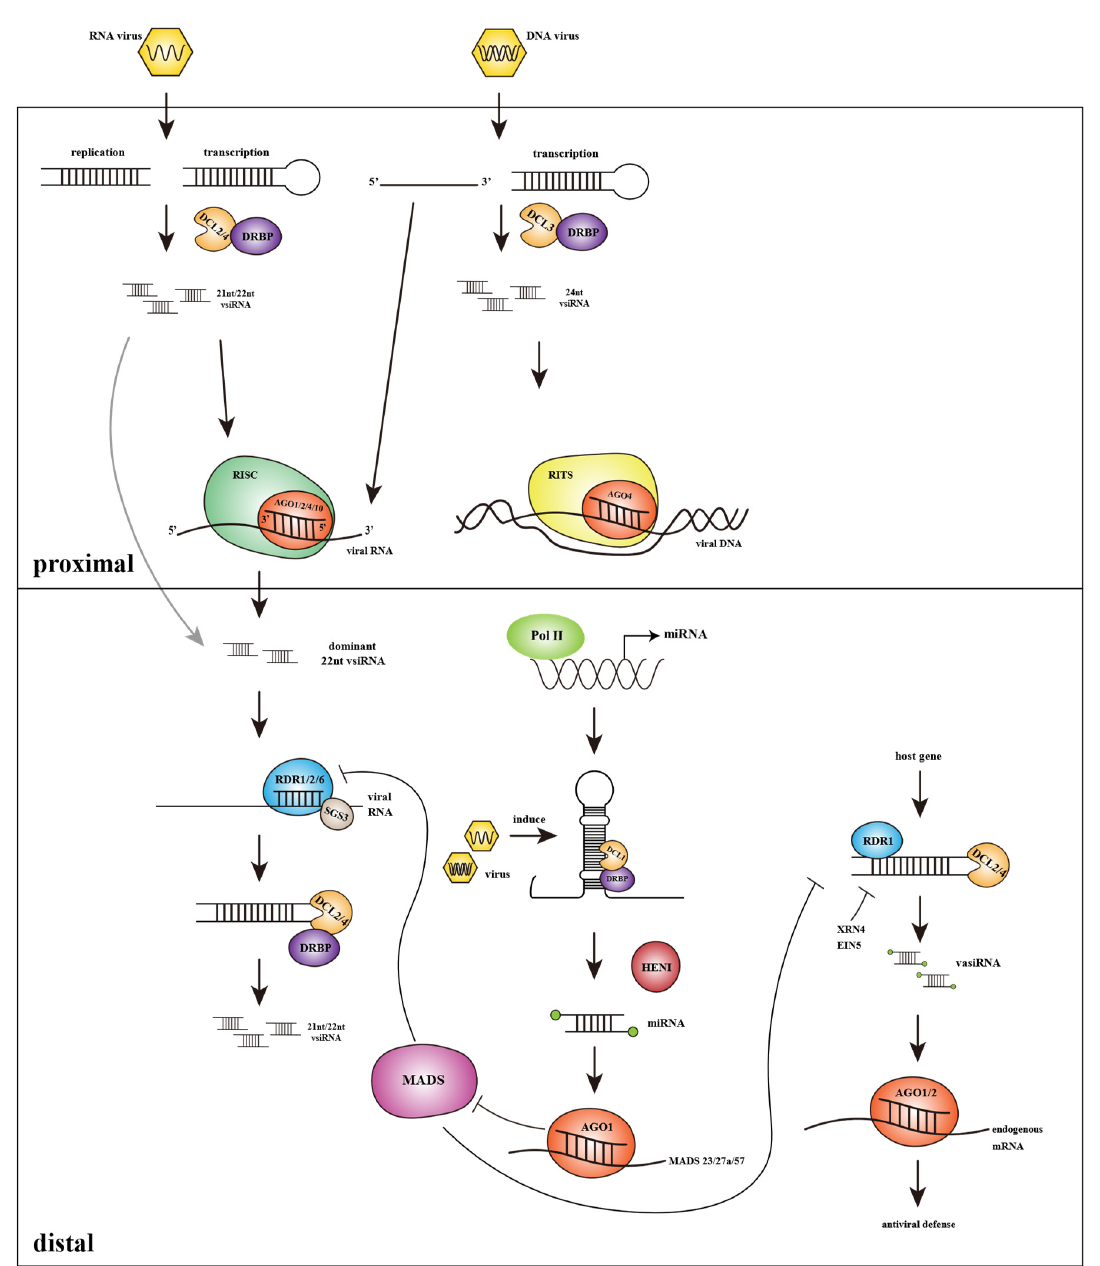
Figure 3. Viral defense pathway driven by host sRNAs and vsiRNAs. Once the virus infects plants, the vsiRNAs generated by DCLs establish the first line of defense in the infected proximal cells by guiding the virus transcript cleavage or mediating the methylation of virus DNA. VsiRNAs will transfer to distal cells and deliver antiviral RNAi with the help of RDRs. In this process, miRNAs and vasiRNAs produced by host plants will participate in the regulation of antiviral defense. Additional abbreviations: DCL, DICER-LIKE; DRBP, double-stranded RNA-binding protein; vsiRNA, virus-derived small interfering RNA; RISC, RNA-induced silencing complex; AGO, ARGONAUTE; RITS, RNA induced transcriptional silencing; Pol II, RNA polymerase II; miRNA, micro RNA; RDR, RNA-dependent RNA polymerase; SGS3, SUPPRESSOR OF GENE SILENCING 3; HEN1, HUA ENHANCER 1; vasiRNA, virus activated small interfering RNA; XRN4, EXORIBONUCLEASE 4; EIN5, ETHYLENE INSENSITIVE 5.